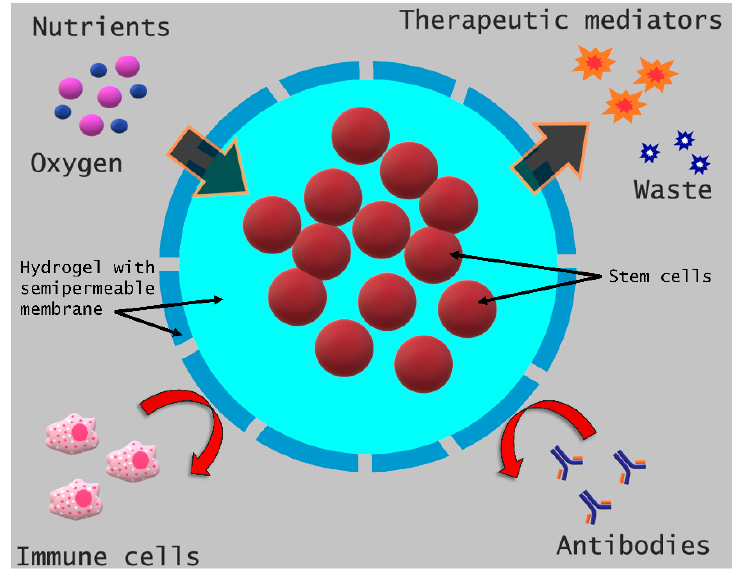
Figure 1. Schematic of stem cell encapsulation and its benefits.